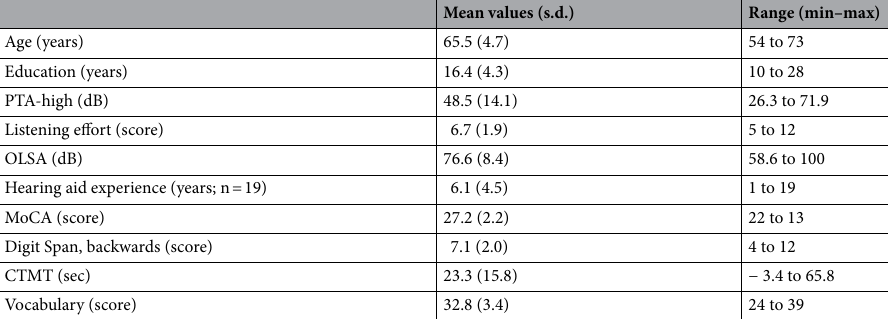
Table 2. Mean values and standard deviations of the demographic, audiological, and cognitive information for the participants (n = 39). Listening effort (subjective) was obtained through a questionnaire asking participants how difficult they found it to understand speech during several everyday situations and activities, such as watching TV. OLSA Oldenburg (Matrix) Sentence Test 37–39 . MoCA Montreal Cognitive Assessment task with a maximal score of 30 33 . CTMT Comprehensive Trail-Making Test, difference between subtests 1 and 5 36 . Vocabulary Wortschatztest , a German vocabulary test with a maximal score of 40 40